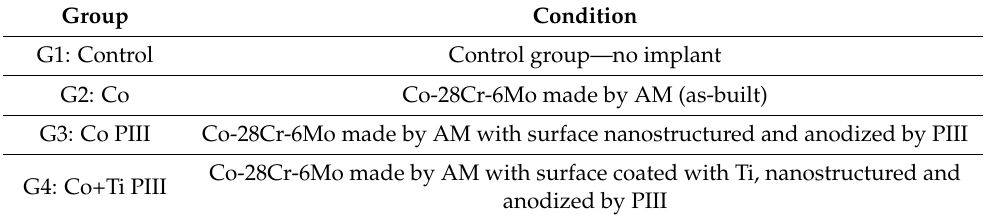
Table 1. Summary of conditions and nomenclature adopted for each group of implants. Group Condition